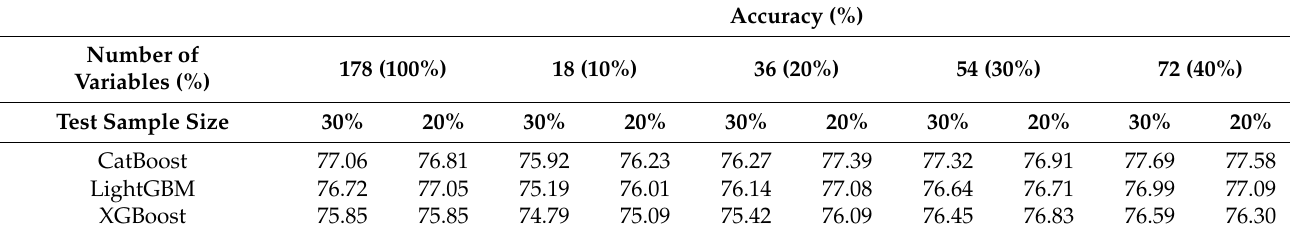
Table 2. Classification accuracy for the DM